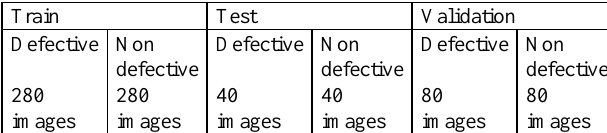
Table 3. Balanced Dataset distribution